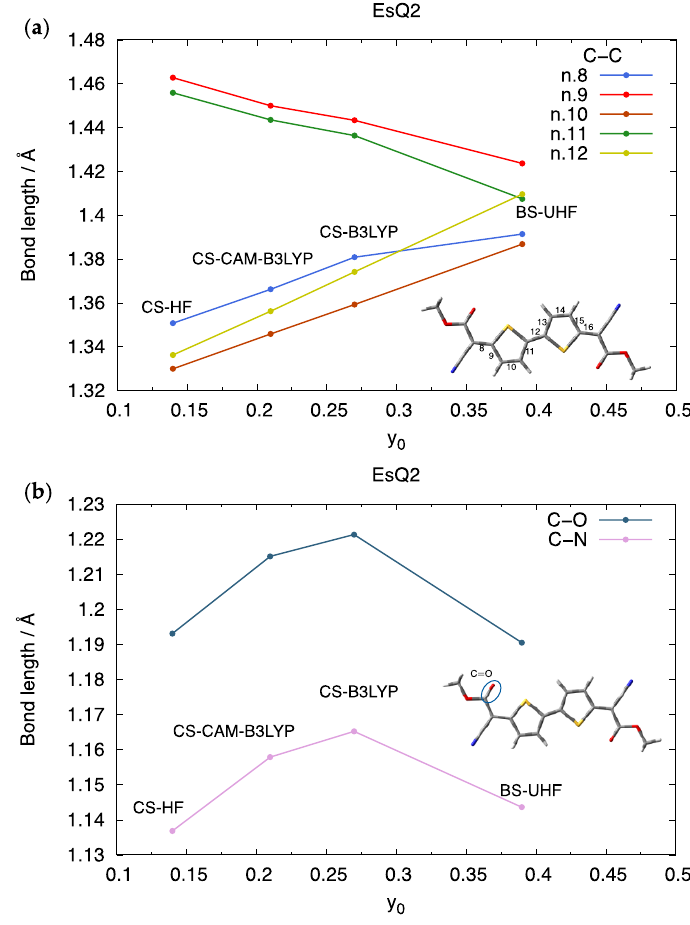
Figure 3. Correlation between 𝑦 0𝑃𝑈𝐻𝐹 and C-C bond lengths ( a ) and C ≡ N/C=O bond lengths ( b ) of EsQ2 calculated at different geometries: CS-HF, CS-CAM-B3LYP, CS-B3LYP and BS-UHF. Bottom right of ( a ): definition of bond number; Center right of ( b ): C=O bond considered in this figure.